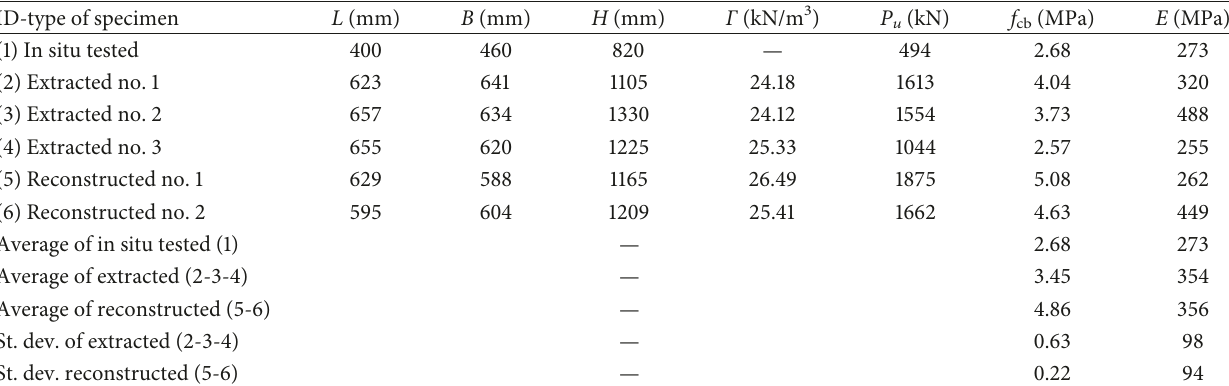
Table 2: ID-type: identification code and class of the wall